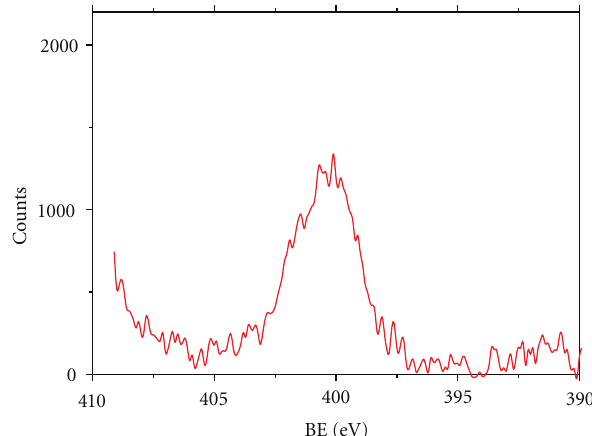
Figure 7: XPS peak of N 1s in the sample TIT 144 ground with ammonium carbamate addition.